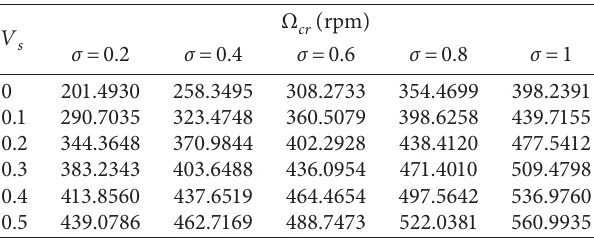
Table 4: The critical rotating speed corresponding to the different SMA wire fractions and taper ratio for S-S boundary condition